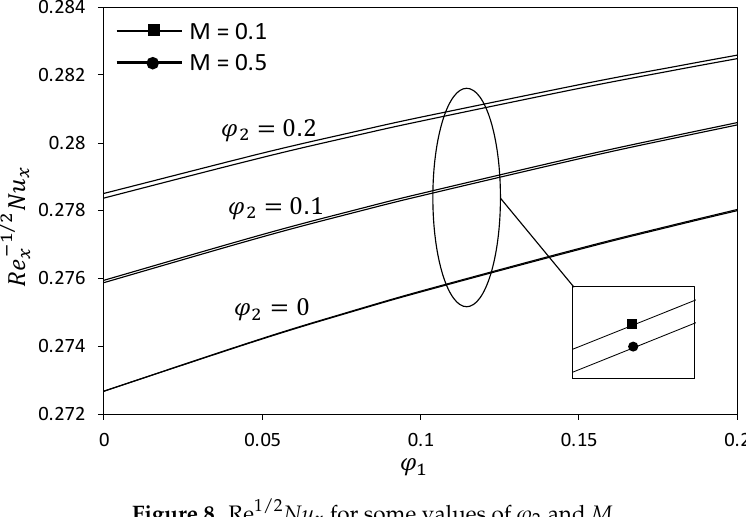
Figure 8. Re 1/2 x Nu x for some values of ϕ 2 and M . Figure 8.